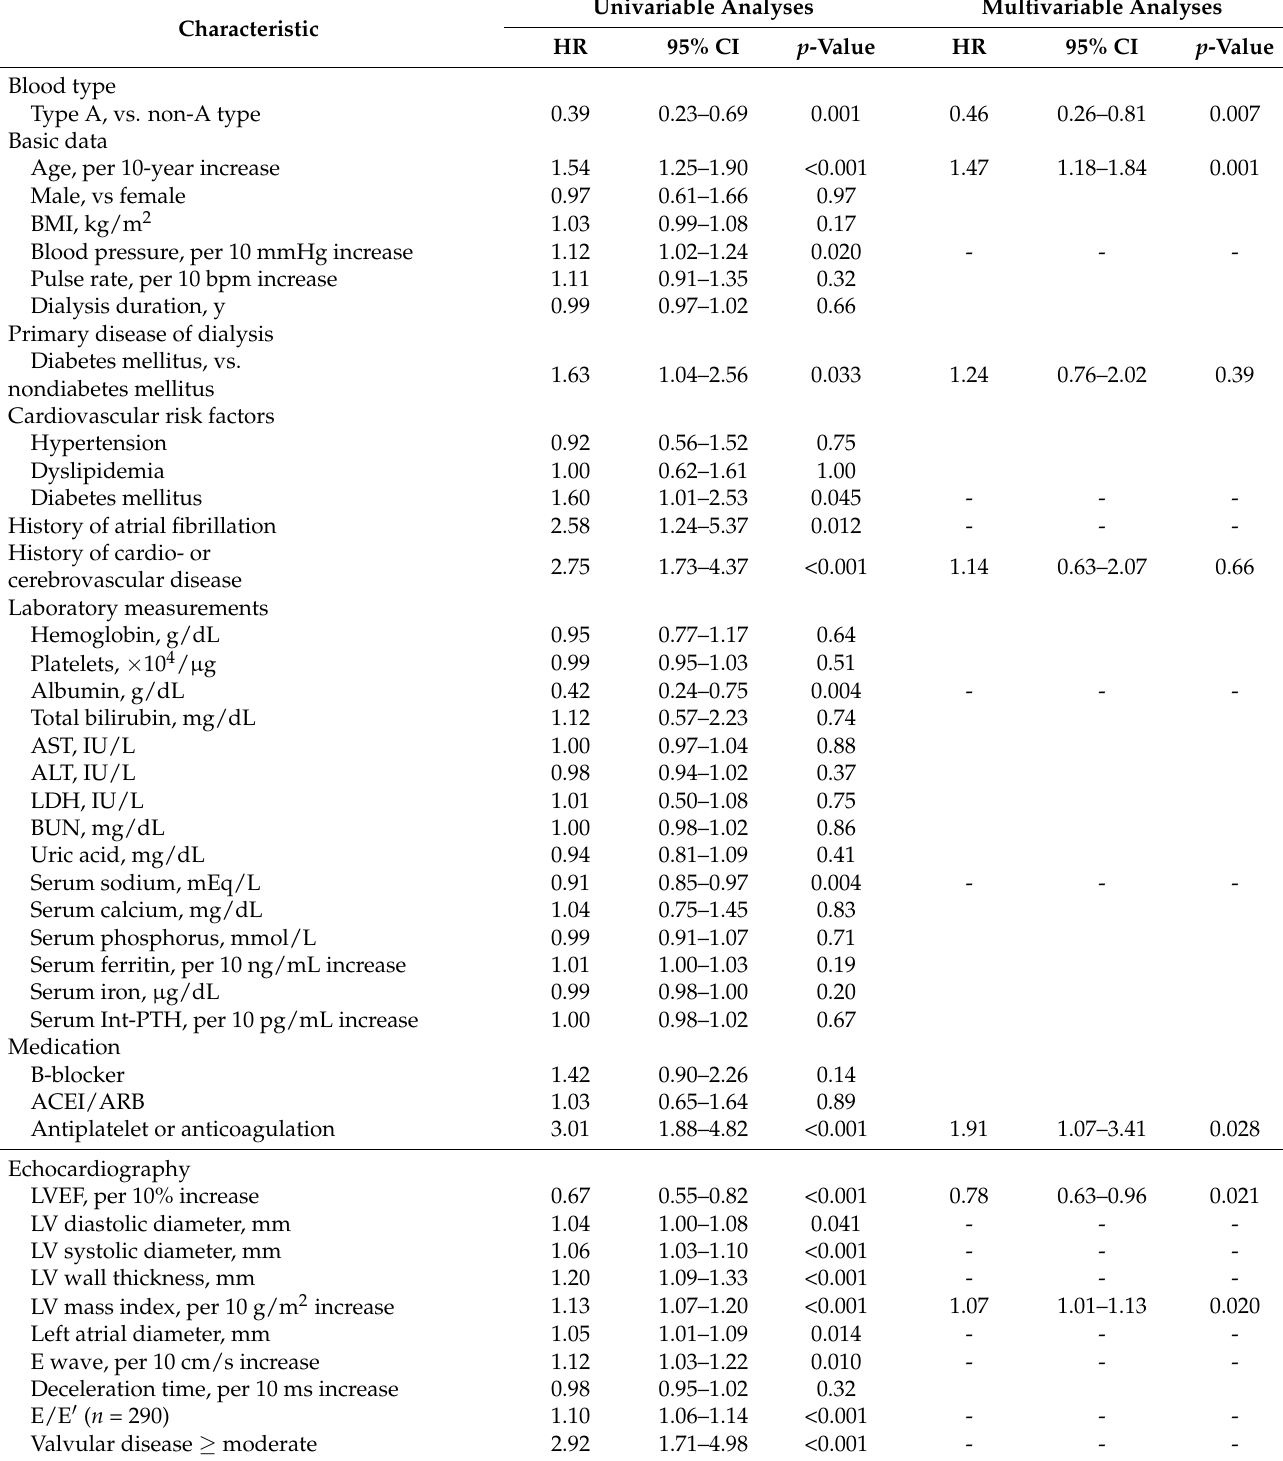
Table 3. Cox proportional hazard